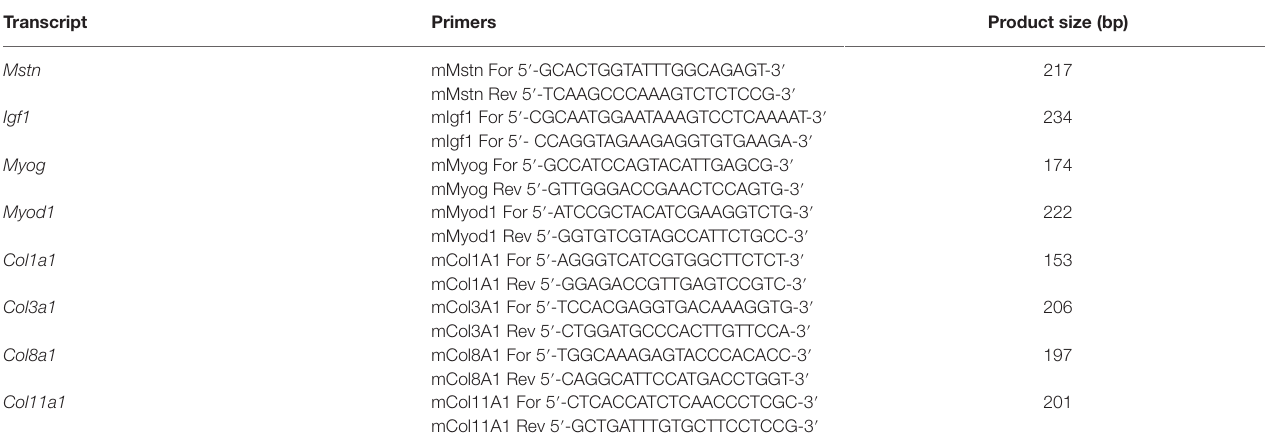
TABLE 1 | Primers used for qPCR